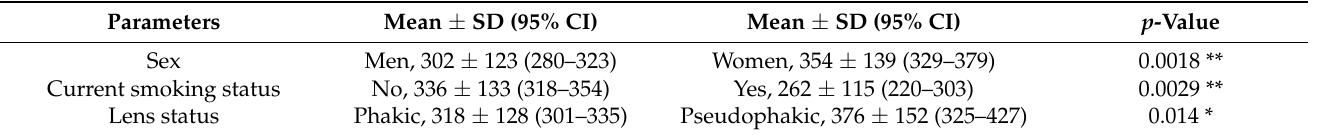
Table 7. Possible association among Veggie score (O.D.) and various categorical parameters.